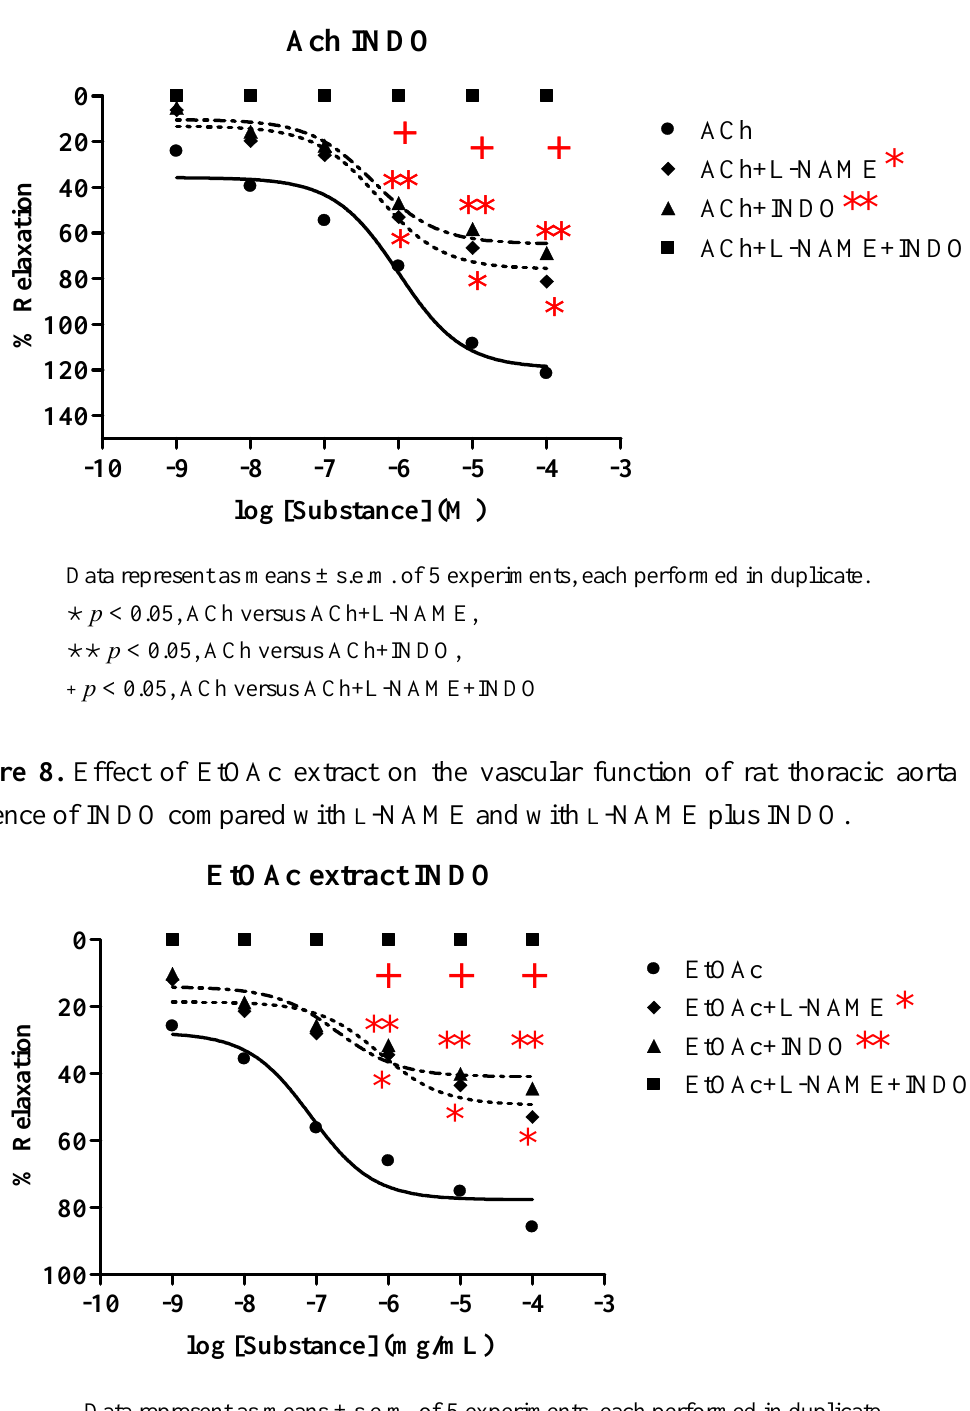
Data represent as means ± s.e.m. of 5 experiments, each performed in